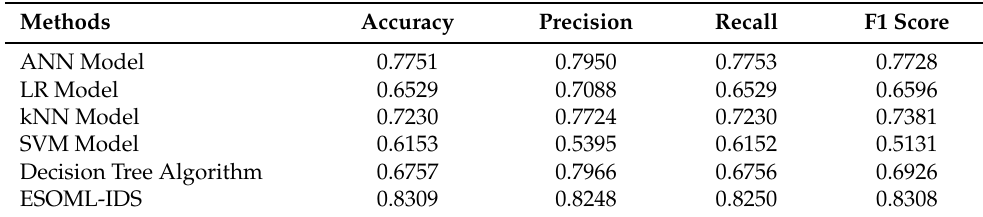
Table 5. Comparative analysis of DAE-IDS technique with feature